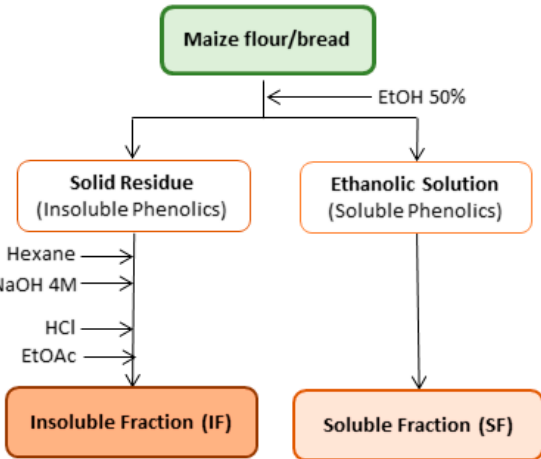
Figure 1. Representative scheme of the extraction procedure of the soluble and insoluble phenolic